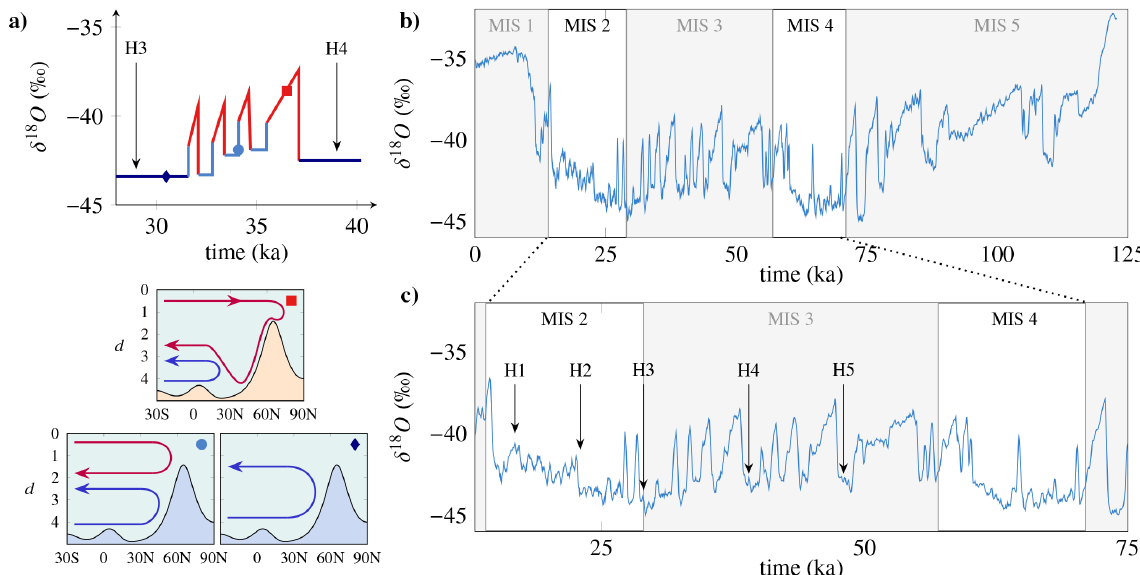
Figure 1. (a) Diagram of a Dansgaard–Oeschger event, alternating hot (red) and cold (blue and sky blue) periods, some of which coincide with a massive iceberg debacle (numbered with an H). A reconstruction of the oceanic circulation during this period (provided in the insets) shows that each phase of this cycle is associated with a different oceanic circulation (Sarnthein et al., 1994). (b) Recording of the rapid climate variability of the last ice age obtained by the δ 18 O isotope profile for the Greenland core. The x axis represents the time spent (ka). Our present time is located at the origin of this axis. We indicate the first five marine isotope stages (MIS) on the graph. Traditionally, the temperature is reconstructed from a relationship between temperature and δ 18 O. However, many biases, such as the seasonality of precipitation or the temperature of regions of evaporation of water masses, lead to an underestimated reconstructed temperature. Thus, the temperature difference between the current period and the last glacial maximum at 21000 years is estimated at 20 ◦ C, while a Dansgaard–Oeschger (numbered) event is estimated between 10 and 16 ◦ C (adapted from Andersen,